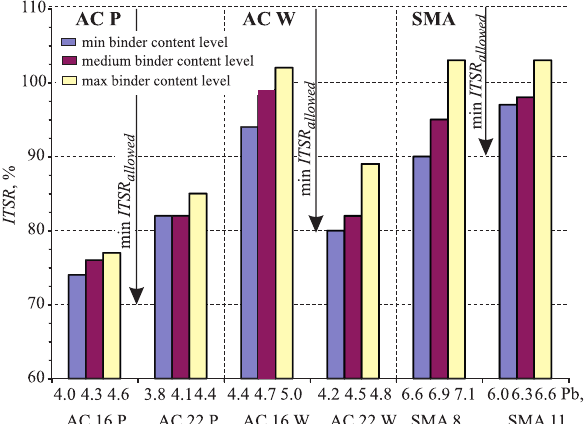
Fig. 6. Test comparison for indirect tensile strength ratio (ITSR) Fig. 7. Comparison of proportional rutting depth